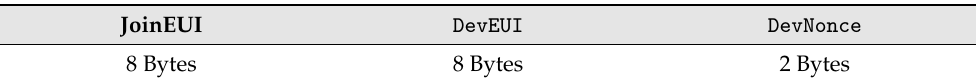
Table 1. Join-Request packet